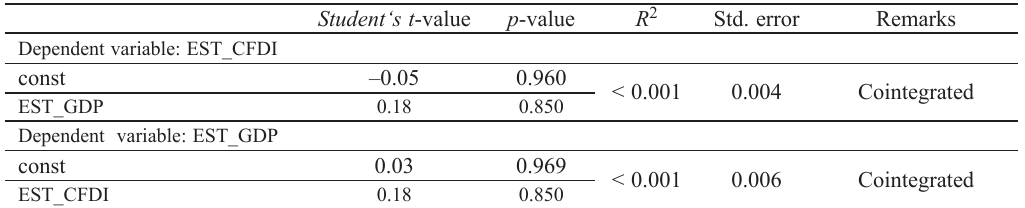
Table 7. Results of EG cointegration tests for